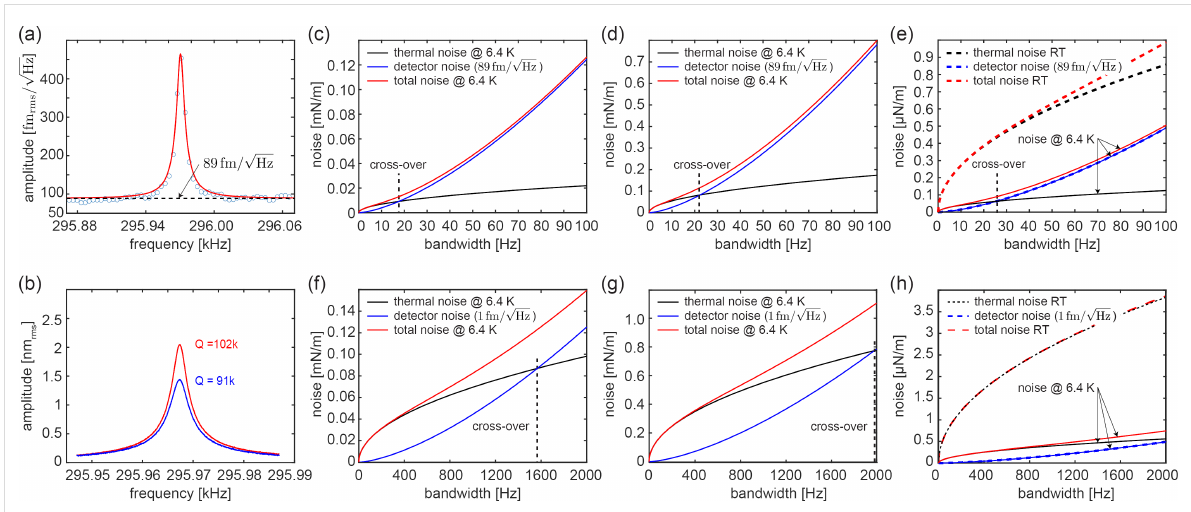
Figure 9: (a) Narrow band thermal noise spectrum of a NCHPt cantilever with length L = 125 μ m and width w = 30 μ m around the cantilever first mode flexural resonance. The fitted resonance frequency and interferometer noise floor are f 0 = 295.95 kHz, and 89 fm/ , respectively. (b) The measured quality factors on the two interferometer slopes are Q damp = 91,000 and Q exc = 102,000. (c, d) Force derivative thermal, detector, and total noise in mN/m for the first and second flexural oscillation mode at T = 6.4 K, an oscillation amplitude A = 100 pm, and a detector noise floor of 89 fm/ , where k 1 = 25.2 N/m, k 2 = 1005 N/m, f 1 = 295.95 kHz, f 2 = 1865 kHz, Q 1 = 100,000, and Q 2 = 10,000. (e) Noise data (here in μ N/ ) for T = 6.4 (solid lines) and T = 300 K (dashed lines) for the first flexural mode of an MFM cantilever [29] with a first mode resonance frequency f 1 = 51 kHz, first mode stiffness of 0.86 N/m, an rms oscillation amplitude of A = 5 nm, and a first mode quality factor Q = 242,000. At higher band- widths, that is, at 18 Hz (first mode), 22 Hz (second mode), and 25 Hz (MFM cantilever at T = 6.4 K), the detector noise becomes the dominant noise source. Panels (f)–(h) display the noise results for bandwidths up to 2000 Hz extrapolated from panels (c)–(e) for a detector noise floor improved to 1